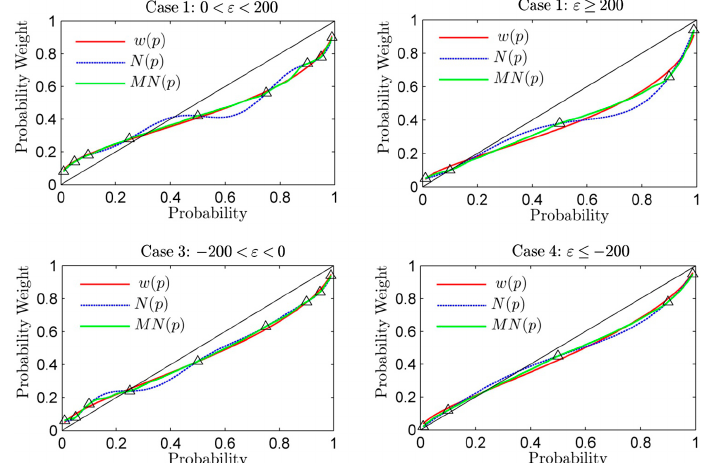
+ and 1 ( ) N p 2 ( ) N p